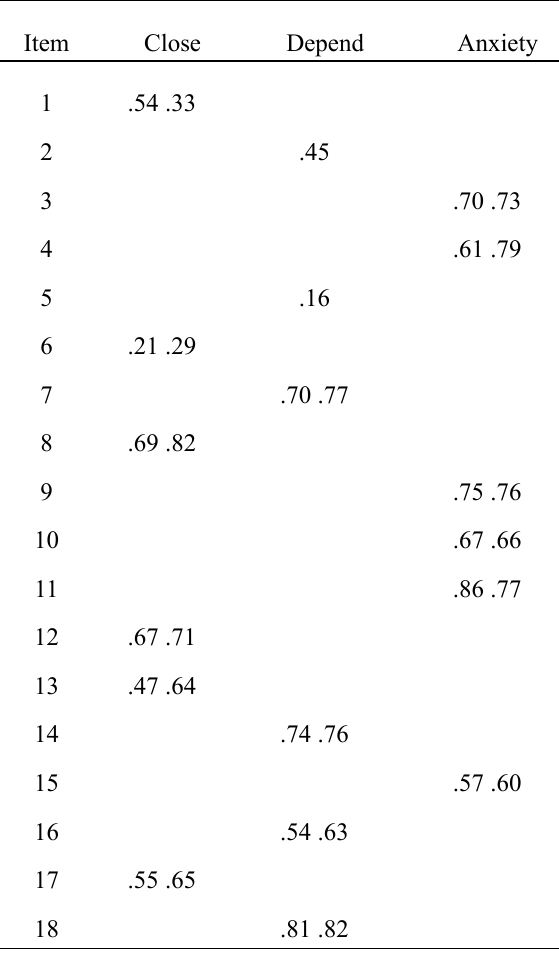
Factor Loadings for the CFAs of Study 1 and 2 on